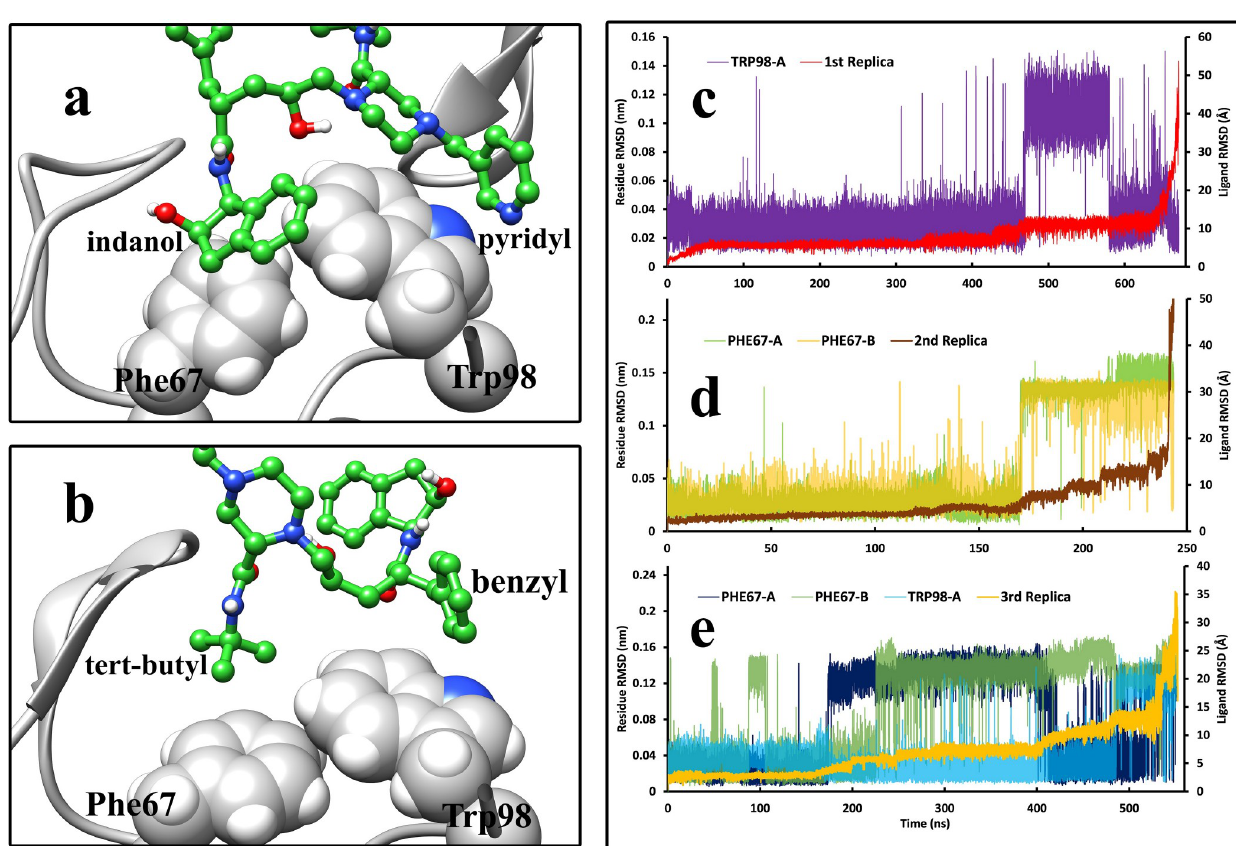
Fig 9. The interactions of Indinavir moieties with the Phe 67 and Trp98 from both chains of HTLV-1 protease during the unbinding pathway and the comparison between the RMSD values of Indinavir ( Å ) and the RMSD values (nm) of critical aromatic residues such as Phe67 and Trp98 in both chains during the unbinding pathways in the three replicas. a , indanol, pyridyl, and, b , tert-butyl and benzyl moieties of Indinavir interacting with the Indinavir molecule in different states. c, The first replica of the unbinding pathway where only Trp98 from chain A showed elevated RMSD values (nm) in comparison to Indinavir RMSD values ( Å ). d, The second replica where the two Phe67 from both chains presented their role in comparing the Indinavir RMSD values ( Å ) and the residues’ RMSD values (nm). e, The third replica where Phe67 from both chains and Trp98 from chain A exhibited their role in the unbinding